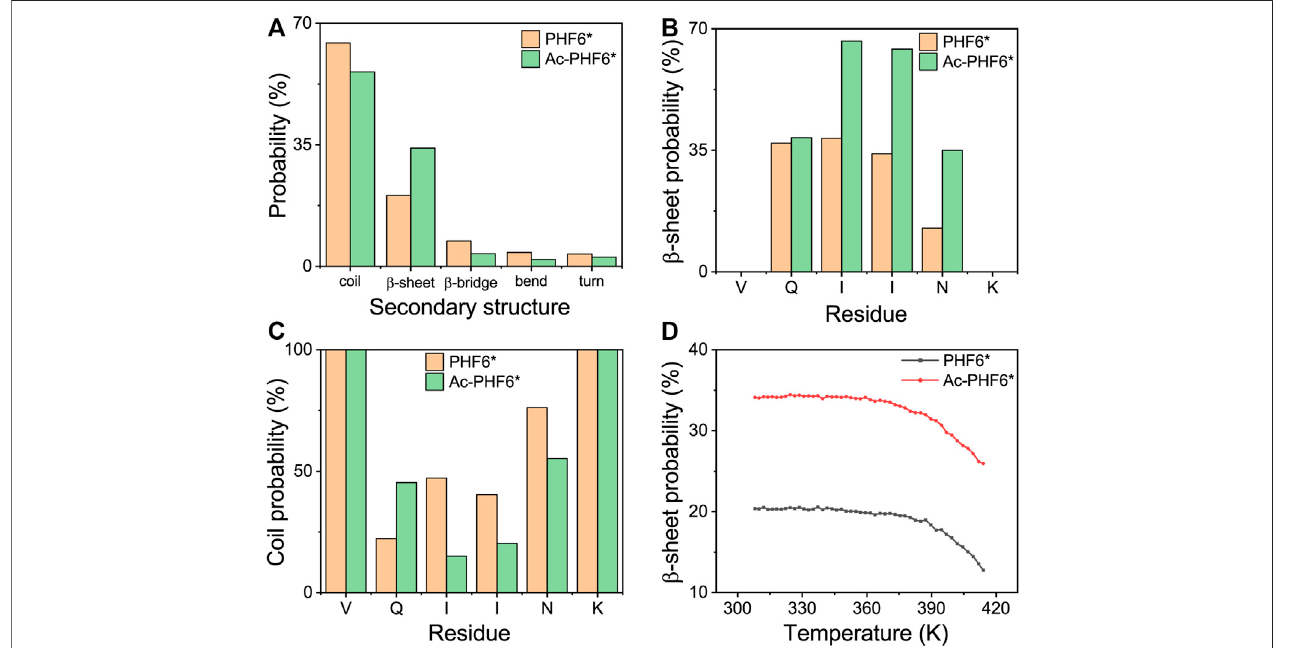
FIGURE 1 | Analysis of secondary structure probability of PHF6* and Ac-PHF6* systems: average probability of each secondary structure (coil, β -sheet, β -bridge, bend and turn) over all residues (A) , probability of β -sheet (B) and coil (C) as a function of each amino acid residue, average probability of β -sheet (D) at different